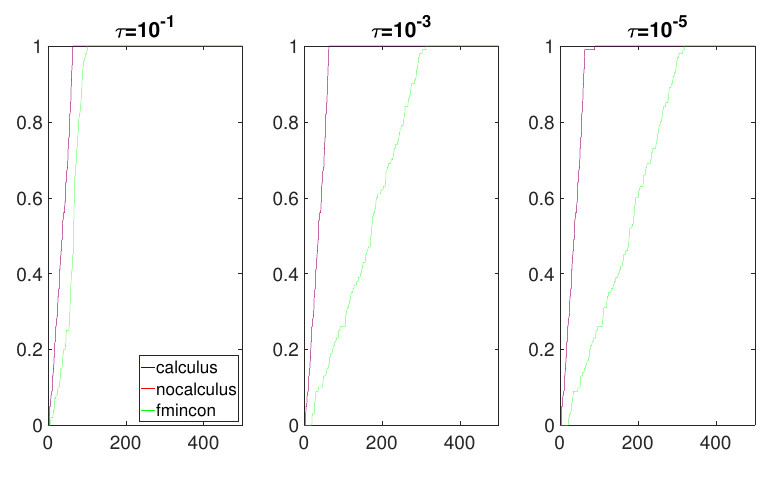
and when f 1 , f 2 are linear functions. f 2